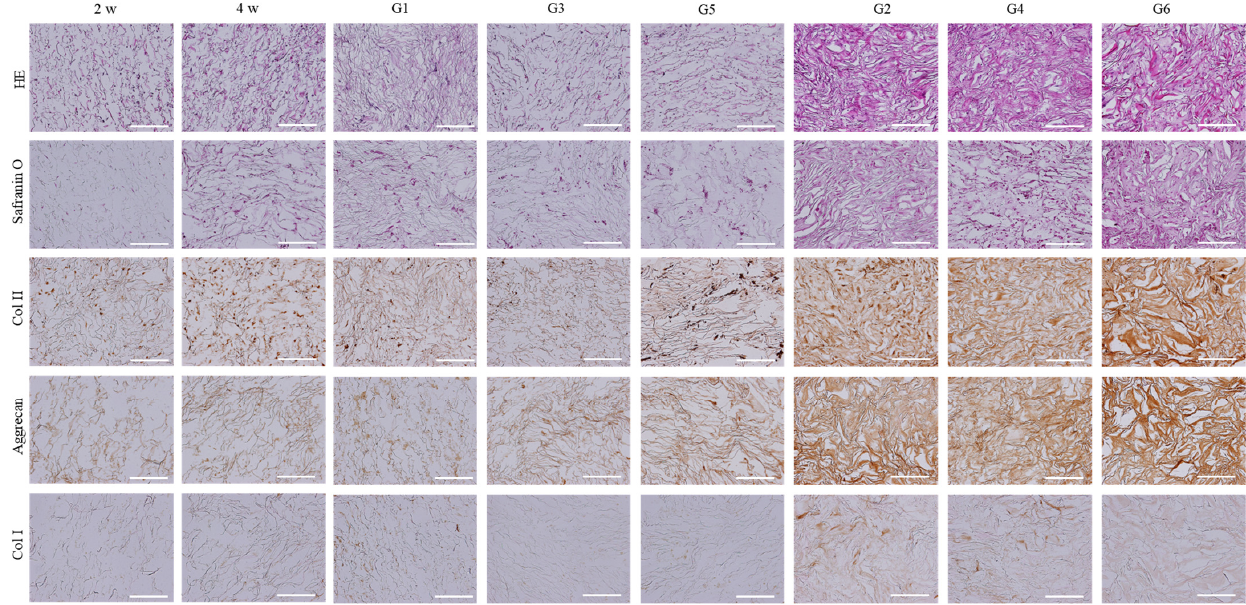
Figure 8. Optical photomicrographs of HE staining, safranin O staining, and immunohistochemical staining of collagen II, aggrecan, and collagen I in the cells/scaffold constructs after in vitro culture for 2, 4, and 8 weeks and in vivo subcutaneous implantation for 4 weeks. Scale bars = 200 µm. Based on all these results, the effects of different culture conditions can be summa- rized as follows. First, culture in collagen porous sponges in proliferation medium was beneficial for proliferation. Second, culture in collagen sponges embedded with hydrogels containing induction factors had the highest promotive effect on chondrogenic differenti- ation. Third, culture in collagen sponges without hydrogel had the second highest pro- motive effect on chondrogenic differentiation. Fourth, culture in collagen sponges embed- ded with hydrogels without loading of induction factors had the lowest promotive effect on chondrogenic differentiation.